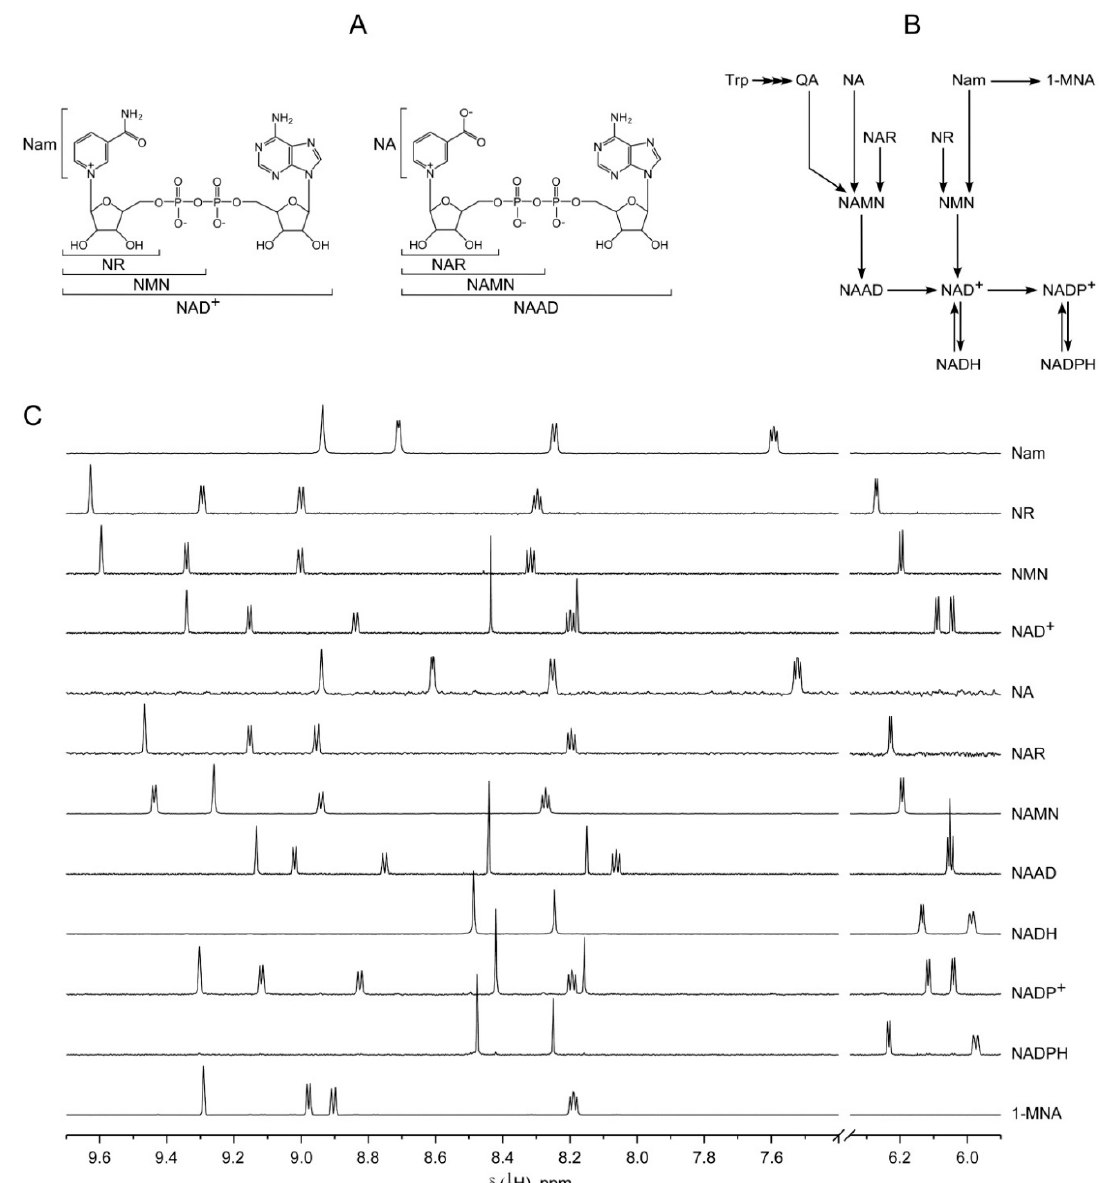
Figure 1. Detection of NAD + and its major intermediates by 1 H NMR spectroscopy. ( A ) Structures of NAD + and its major intermediates. ( B ) Schematic overview of nicotinamide adenine dinucleotide (phosphate) NAD(P) biosynthetic pathways in humans. ( C ) 700 MHz 1 H NMR spectra of NAD + and its major intermediates. Only signals used for analysis are shown. Metabolites were dissolved in 50 mM sodium phosphate buffer in D 2 O (pH 6.5). 1 mM sucrose was used as a chemical shift reference ( δ (1H), 5.42 ppm) and internal standard for quantification. Table 1. Proton nuclear magnetic resonance ( 1 H NMR) spectral parameters of NAD and its major intermediates. Metabolite δ , ppm M, Class J’s, Hz